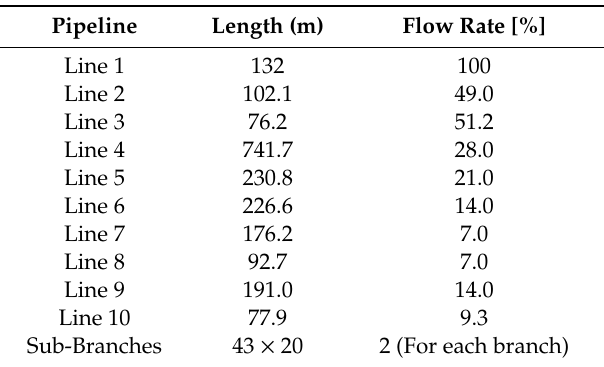
Figure 8. ( a ) Main pipeline location; ( b ) Plan of supply and return of main and sub-branches pipelines. Table 2. Pipeline specifications.